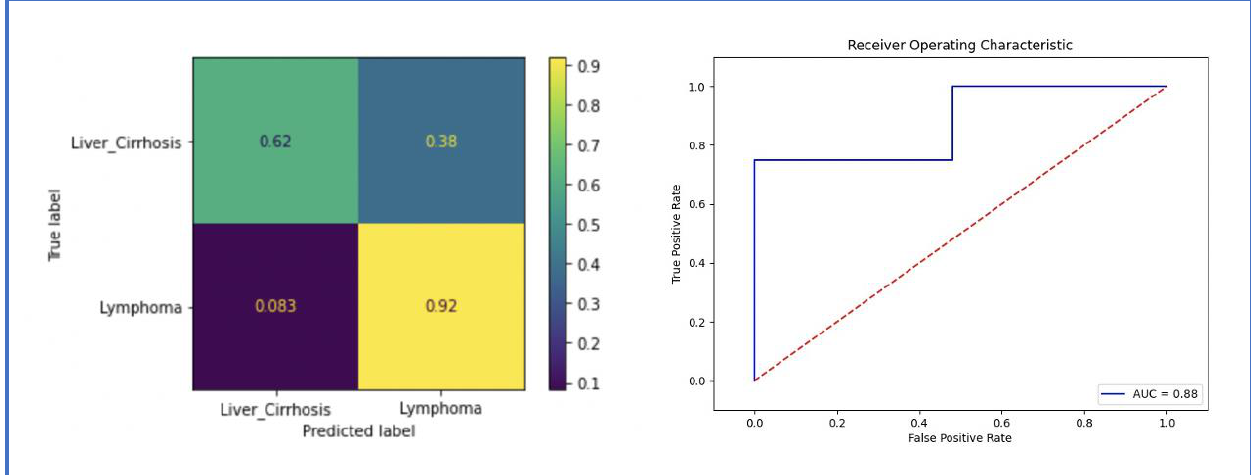
Figure 5. The receiver operating characteristic (ROC) curve and the confusion matrix of the classification model in the testing cohort using the whole abdominal volume (Dense-2).